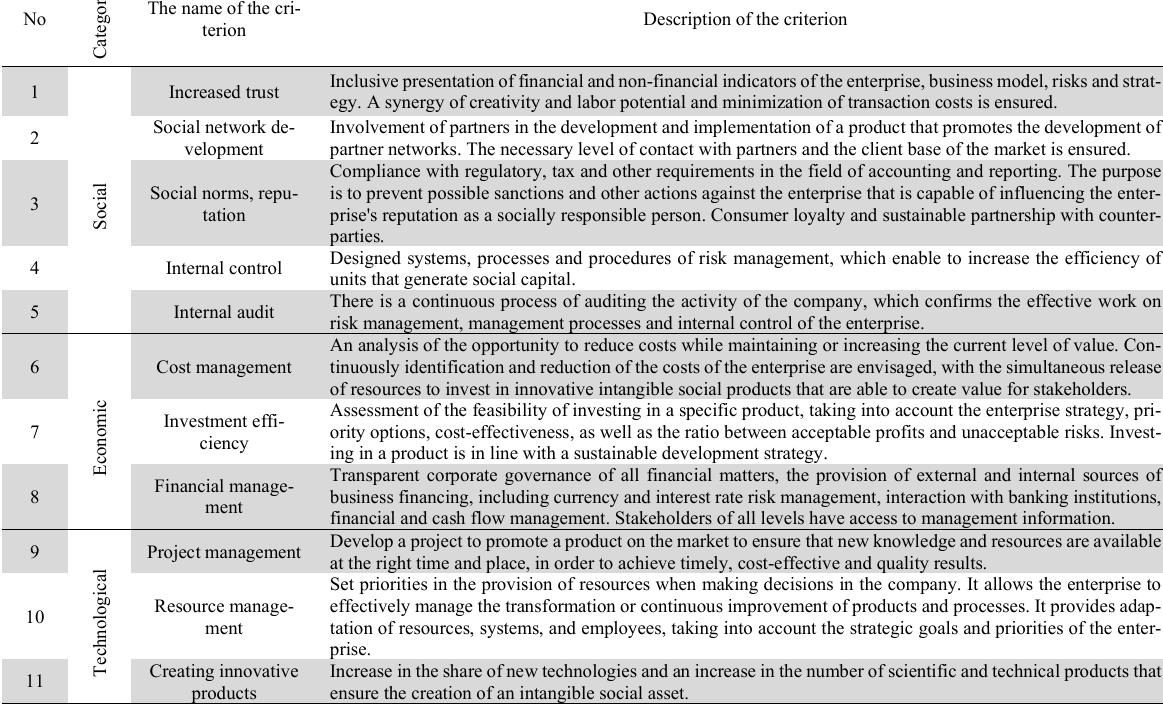
Description of the criterion